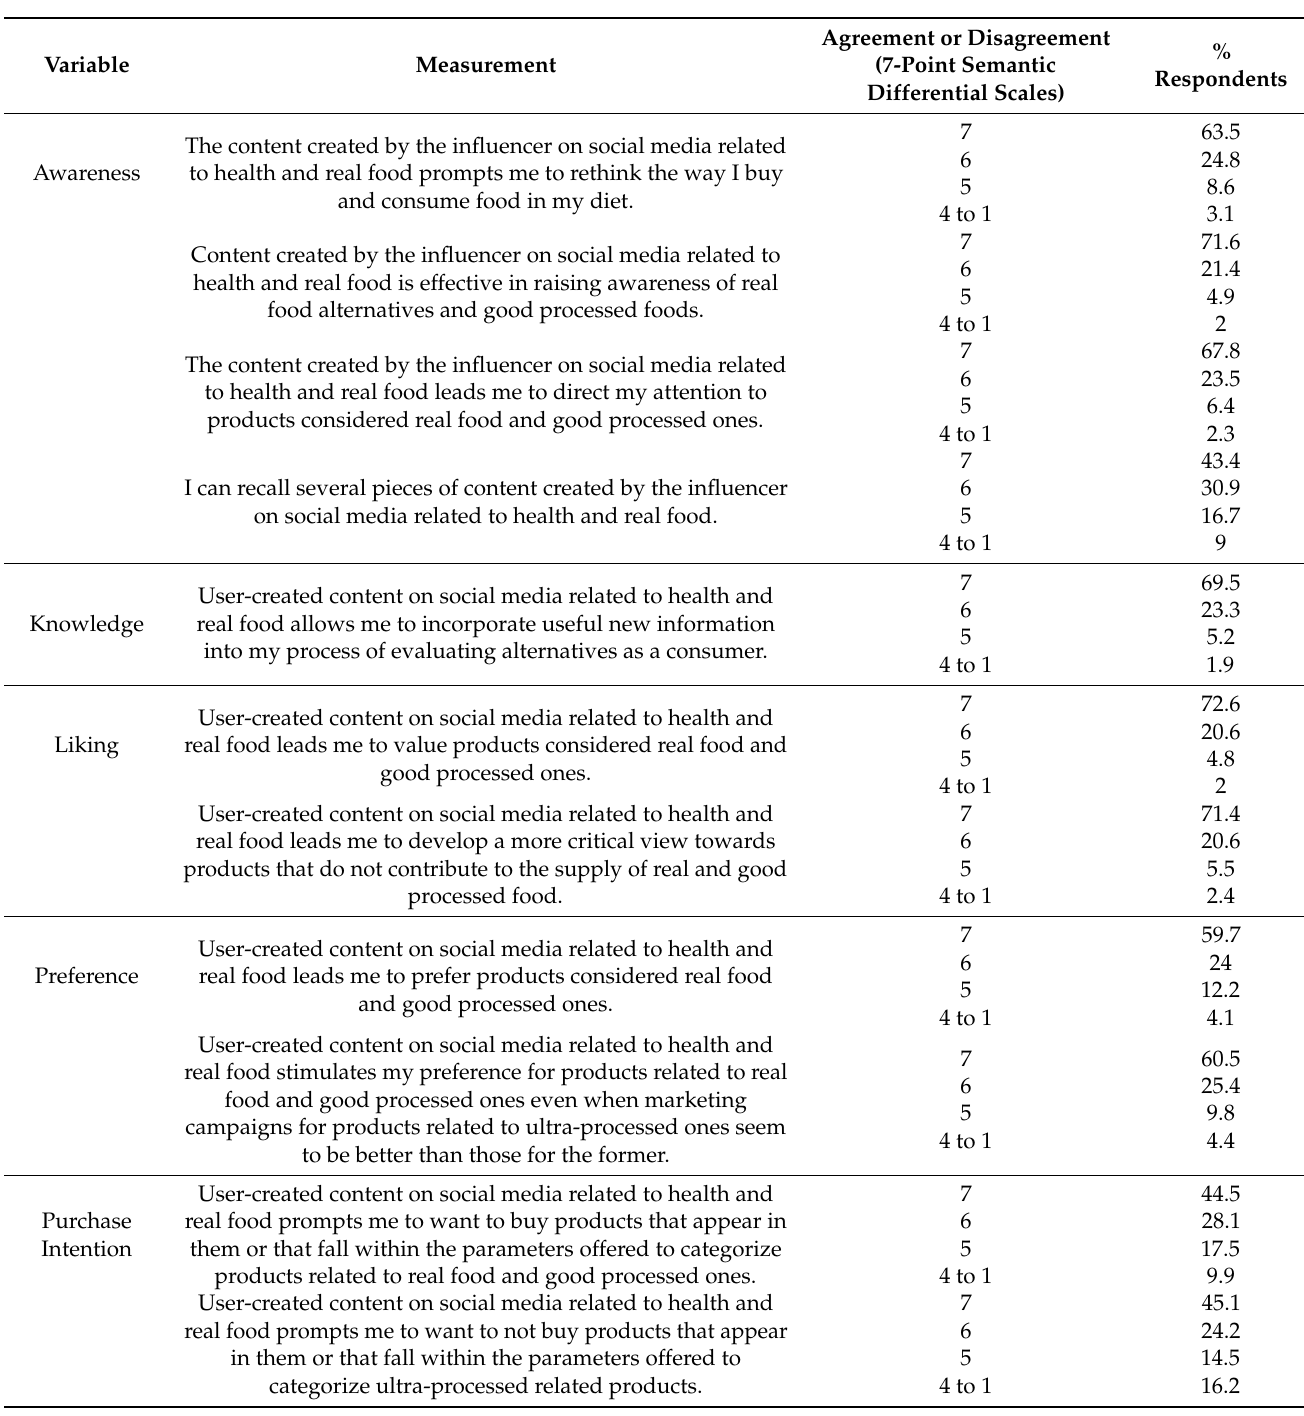
Table A2. Descriptive analysis of the study